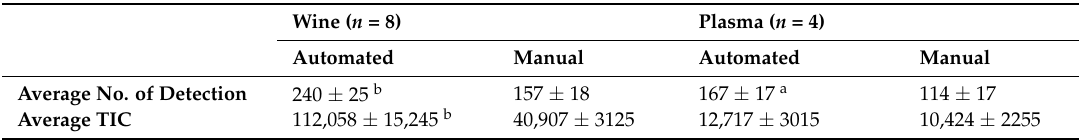
Table 1. Number of detections and total ion chromatogram (TIC) areas obtained from both automated and manual trimethylsilyl (TMS) derivatisation methods in wine and plasma samples. Wine ( n = 8) Automated Manual Automated Manual Average No. of Detection Here, a indicates p -value < 0.05 and b indicates p -value <